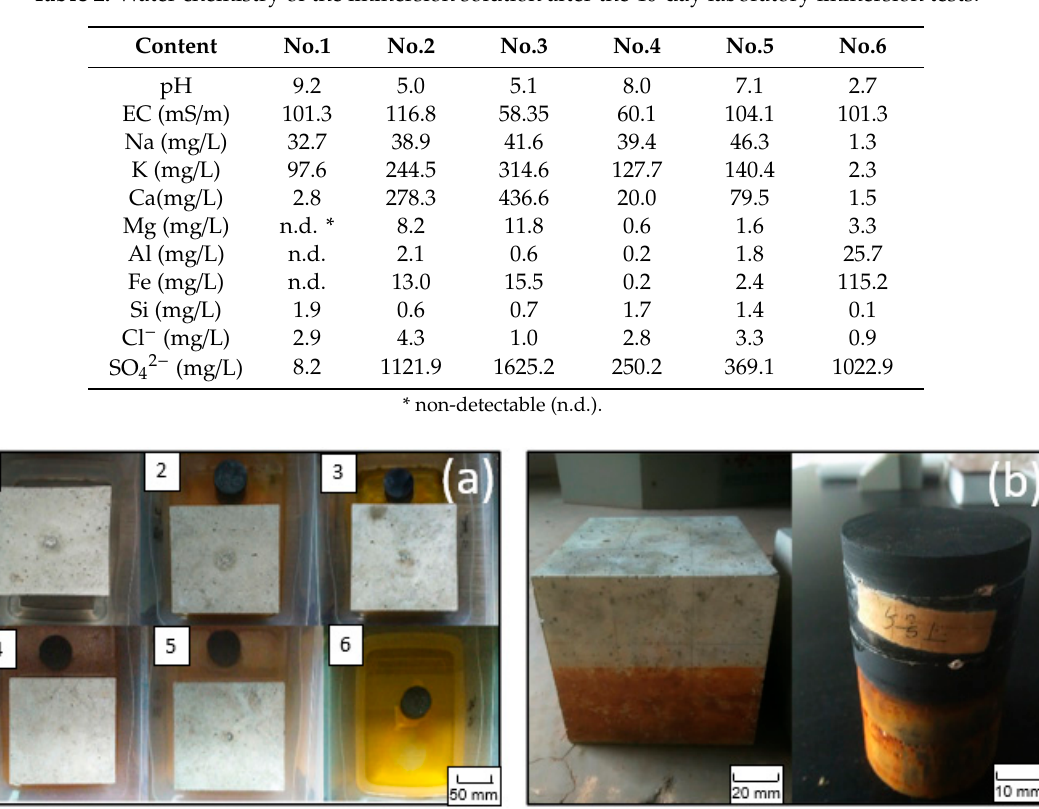
Table 2. Water chemistry of the immersion solution after the 40-day laboratory immersion tests.